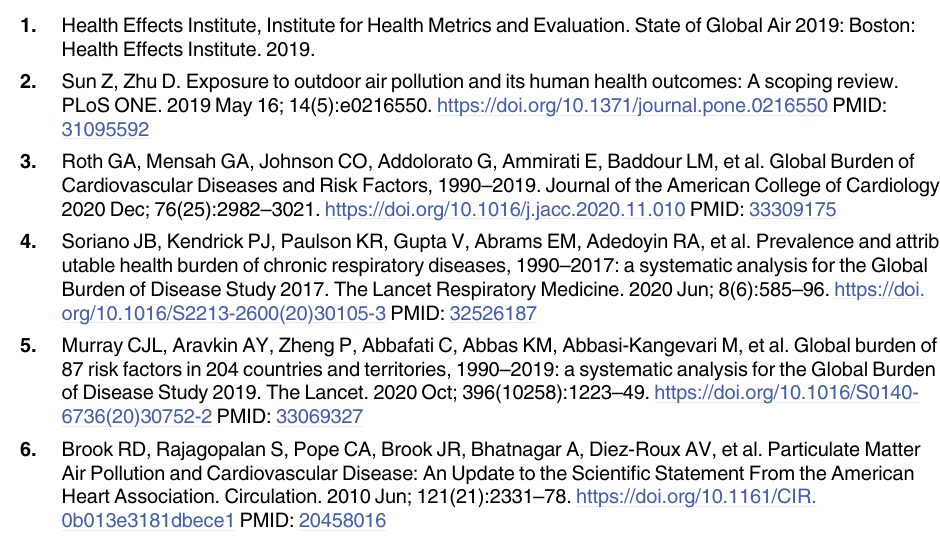
S6 Table. Pollutant concentration differences between event days and average concentra- tions over the control period in Rio de Janeiro, Brazil (2012–2017). � Differences between daily concentrations of each pollutant on event days (day of death) and average concentrations over the control period. �� Difference between pollutant concentrations in event and control days using all the mortality data (geocoded and non-geocoded) and daily average exposure data (all stations without imputation and IDW interpolation). PM : Particulate 10